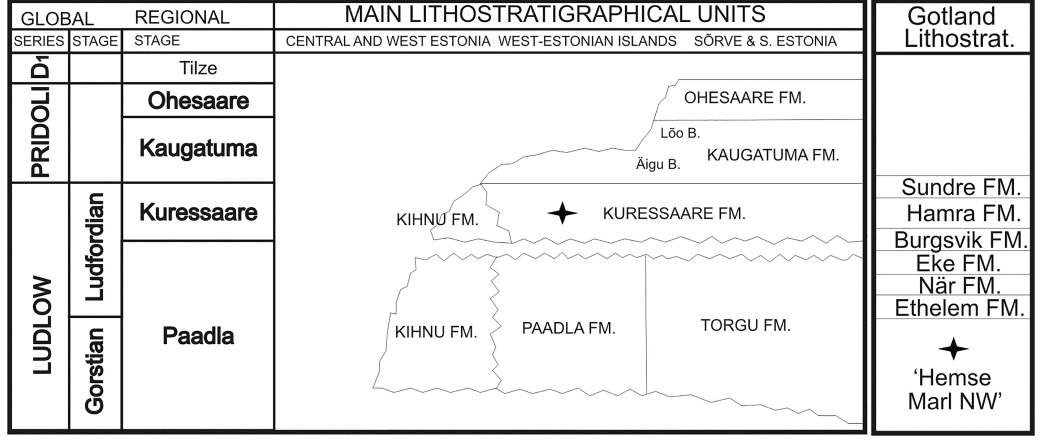
Fig. 2. Lithostratigraphical scheme showing the position of the Kuressaare Formation in Saaremaa Island, Estonia and Hemse Beds in Gotland, Sweden (based on Hints et al. 2008). B., Beds; Fm.,